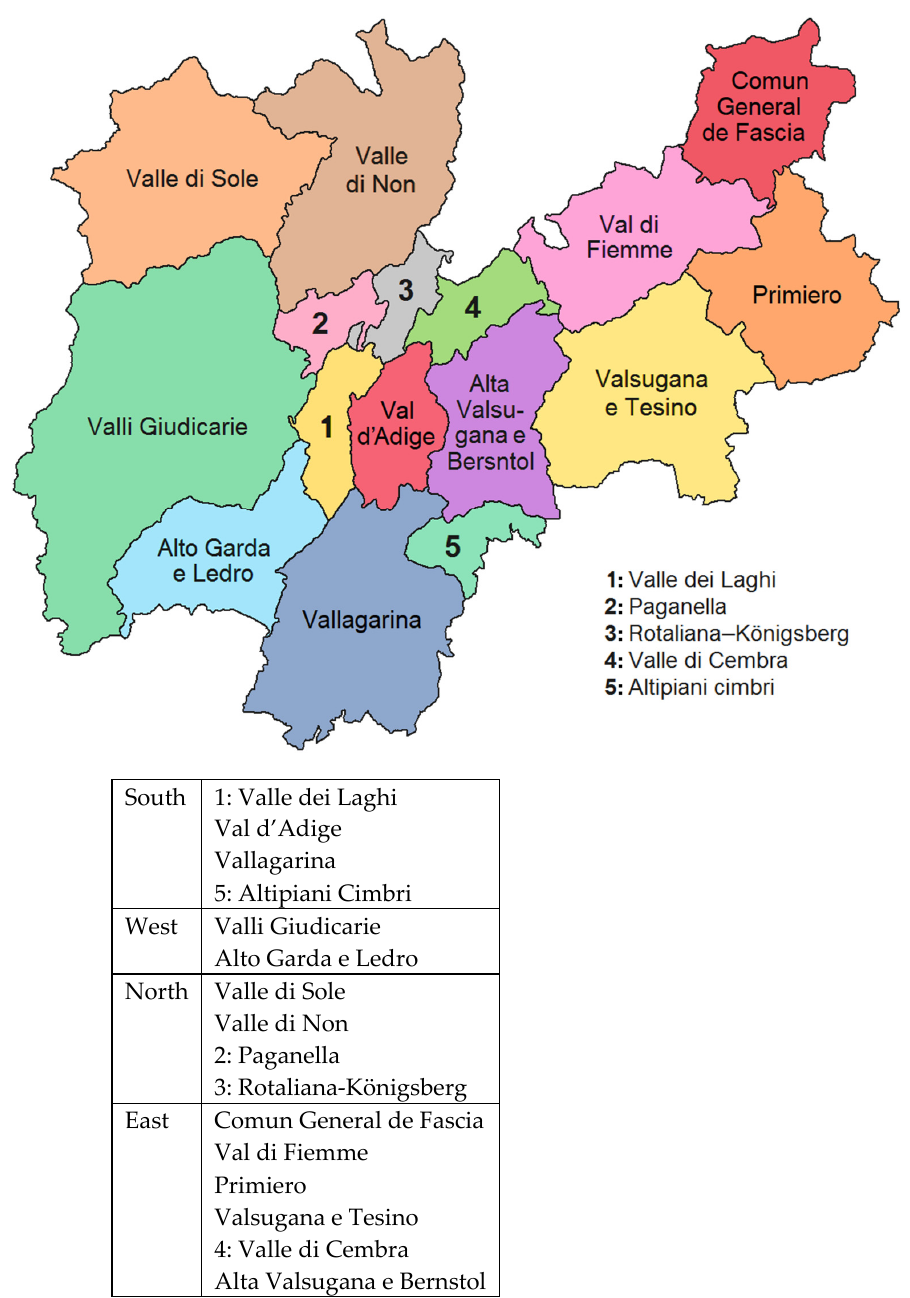
Figure 1. Geographical areas of the Province of Trento, Italy, and their aggregation according to South, West, North and East.